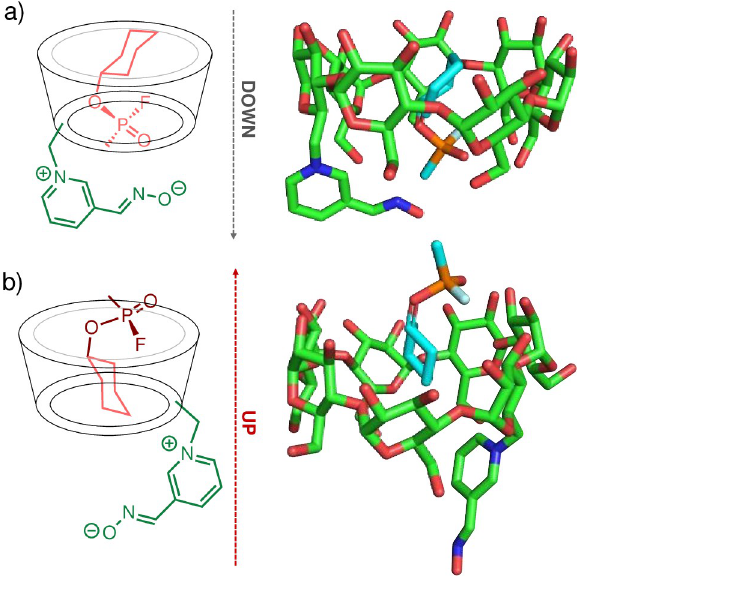
Fig 9. ns). Interestingly, during the ‘up- ’ simulation, the P � � � O distance lies between 12–15 GD GF Oxime Å which effectively makes this conformation an unlikely model to explain 6-OxP-CD’s degra- dative capacity towards GD (Fig 12C). It is in this conformation that P � � � O distances GF Oxime lying beyond 11 Å can be observed with time intervals of > 40 ns highlighting its inability to be of any use in GD degradation. Analysis of the COM data for the GD:6-OxP-CD complex shows very similar results to those found for the GF:6-OxP-CD complex. The distances